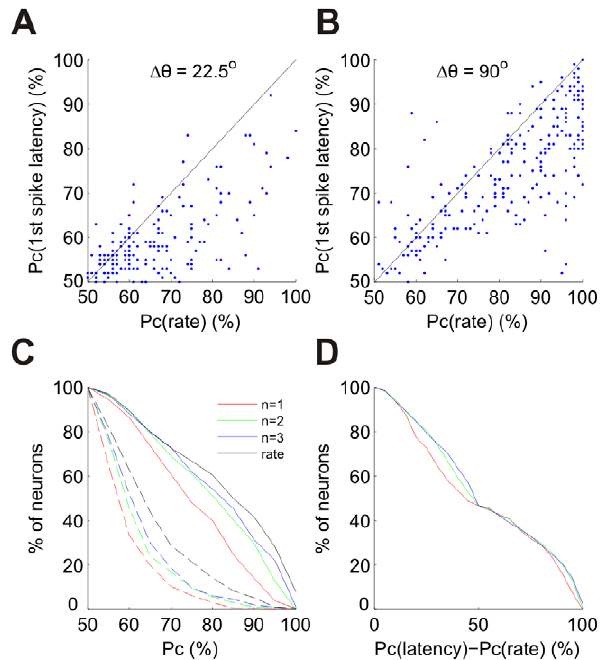
Figure 6. Statistics of orientation discrimination using single cell spike latencies and firing rates. (A)–(B) Pc (probability of correct discrimination) using first spike latency vs. Pc using the spike count of the entire response. Each point corresponds to a single cell. The identity line is shown for comparison (solid black line). (A) Comparison of performance at a fine resolution discrimination task, Dh =22.5 u . (B) Comparison of performance at a coarse resolution discrimination task, Dh =90 u . (C) Proportion of cells above a given performance level. The dashed curves correspond to a 22.5 u discrimination task and the solid curves to a 90 u discrimination task. Different curves correspond to first spike latency (red), second spike latency (green), third spike latency (blue) and firing rate from the entire response (black). (D) Comparison of latency and rate performance at a given decision time. The abscissa is the difference between Pc using the n ’th spike latency and Pc of the conventional rate code readout, where the rate is estimated from the spike count in the time window from stimulus onset to the mean decision time using the n ’th spike latency. These differences correspond to the vertical distances between the circles and the solid black curve in the right panels of Figure 5. The curves show the proportion of cells above a given difference. The color code is the same as in (C). The data for all panels are from the tuned cells ( B . 15 ms) in datasets 1, 2, 4 and 5 in Table 1 (244